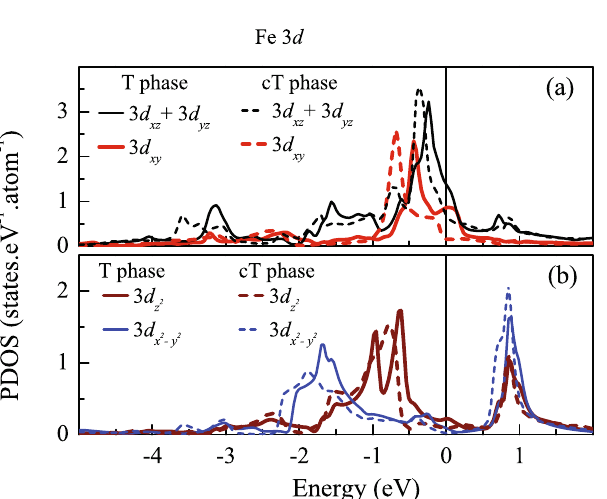
Figure 5. Comparison of the partial density of states of various Fe 3 d orbitals in tetragonal (T)-phase (solid lines) and collapsed tetragonal (cT) phase (dashed lines). ( a ) 3 d xz + 3 d yz and 3 d xy are shown by thin black line and thick red line, respectively. ( b ) d 3